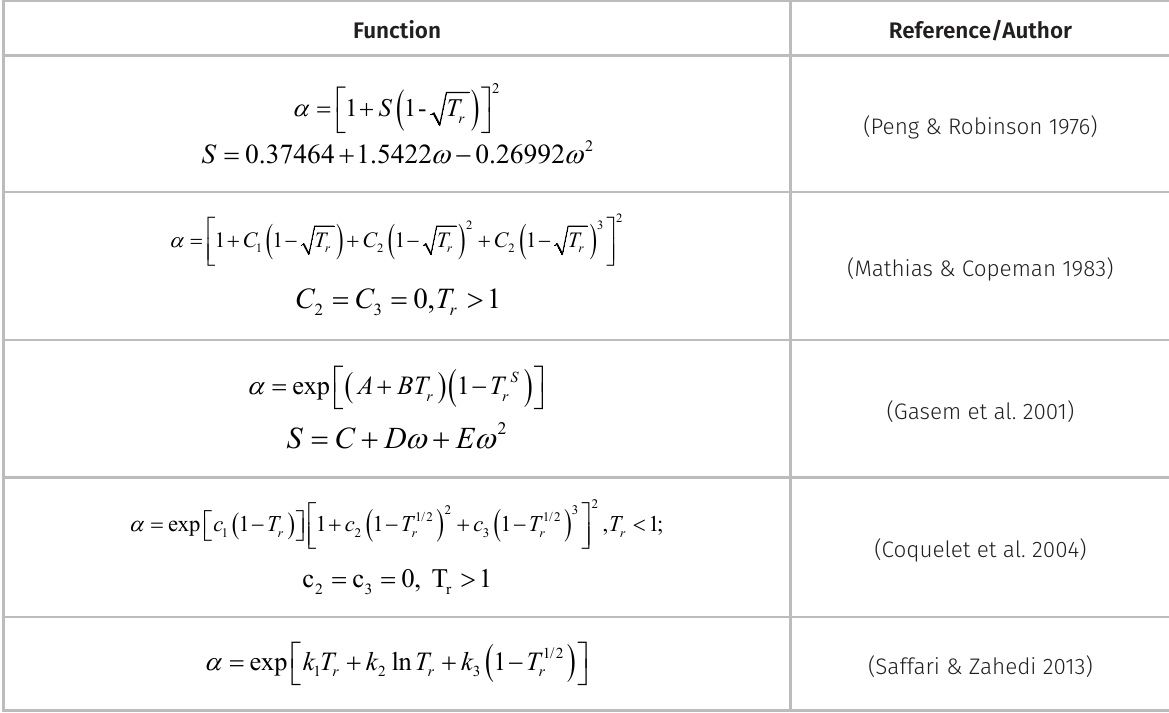
Table I. Alpha functions.